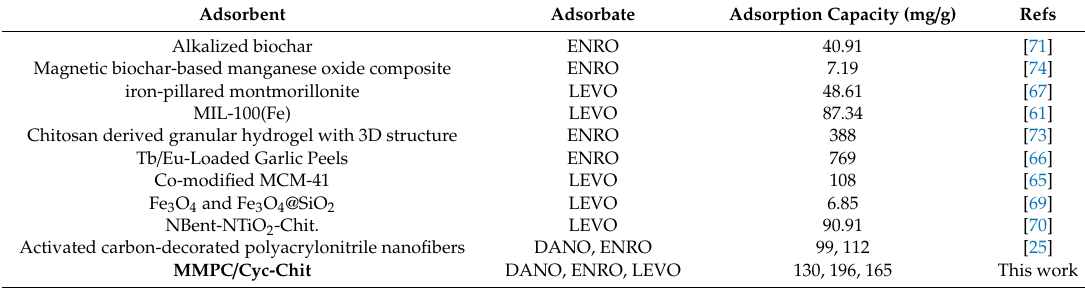
Table 7. Comparison of sorption capacities for DANO, ENRO and LEVO fluoroquinolones with various composite sorbents at 25 ± 1 ◦ C.